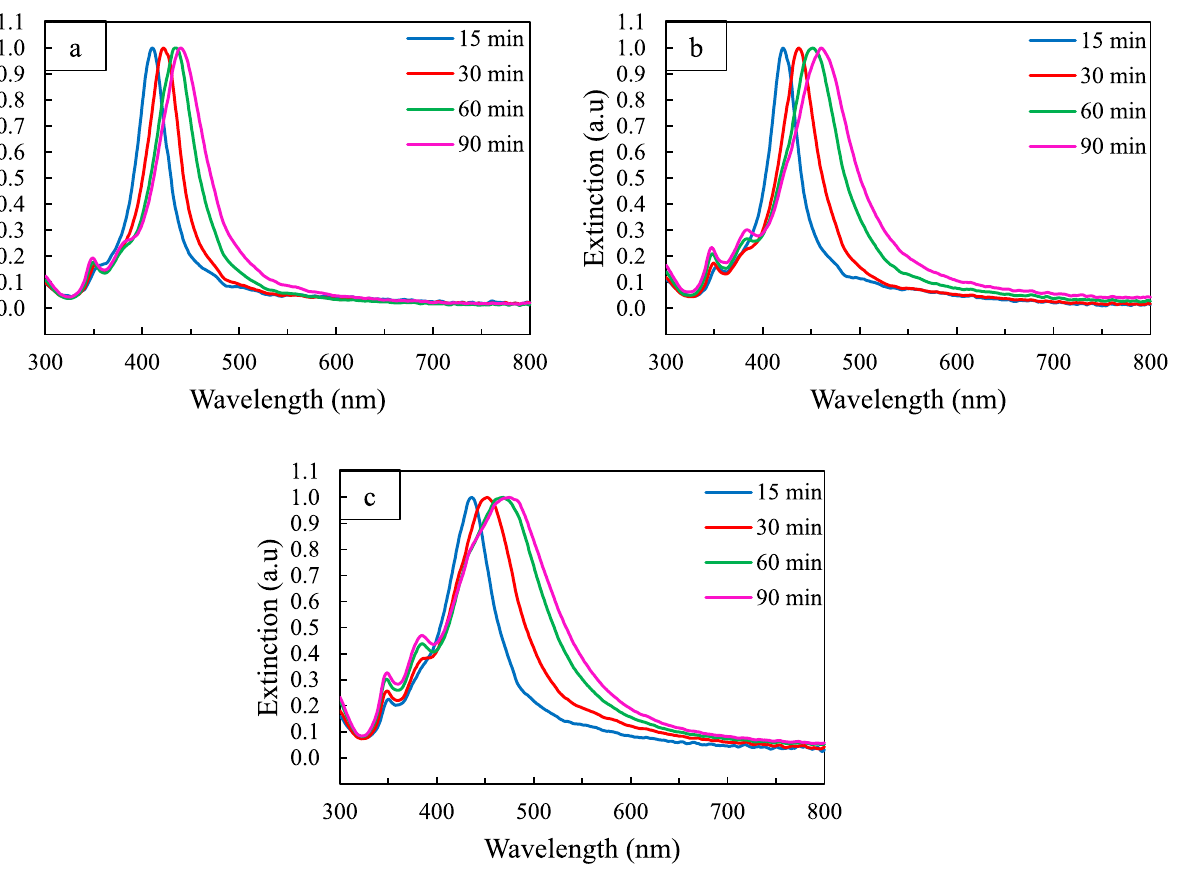
Figure 1. UV–Vis spectra of Ag nanoparticles aliquots collected at different reaction times in different light condition ( a ) dark, ( b ) room light, ( c ) 200-W incandescent